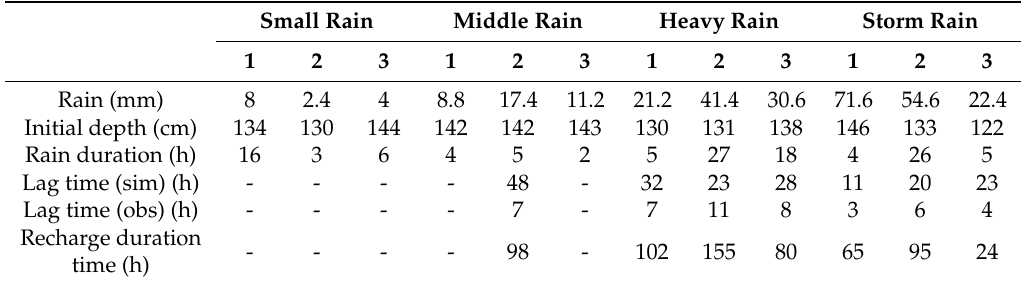
Table 8. Groundwater recharge lag times and recharge durations after precipitation. Small Rain Middle Rain Heavy